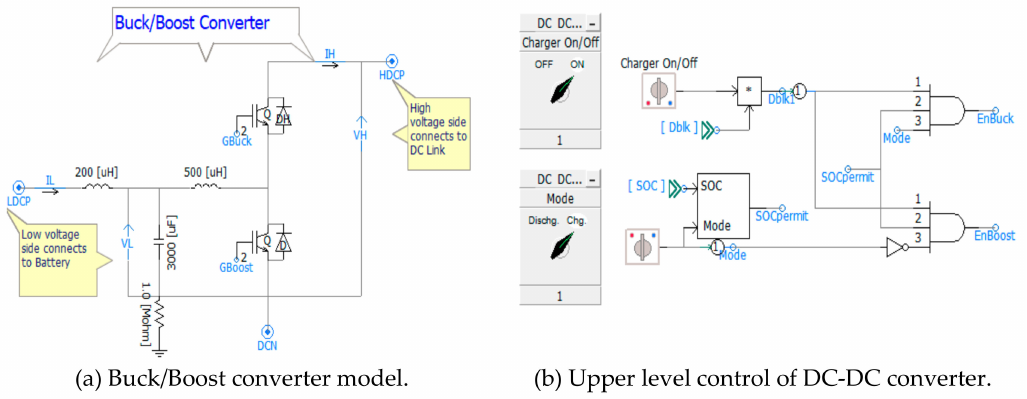
Figure 6. Model of